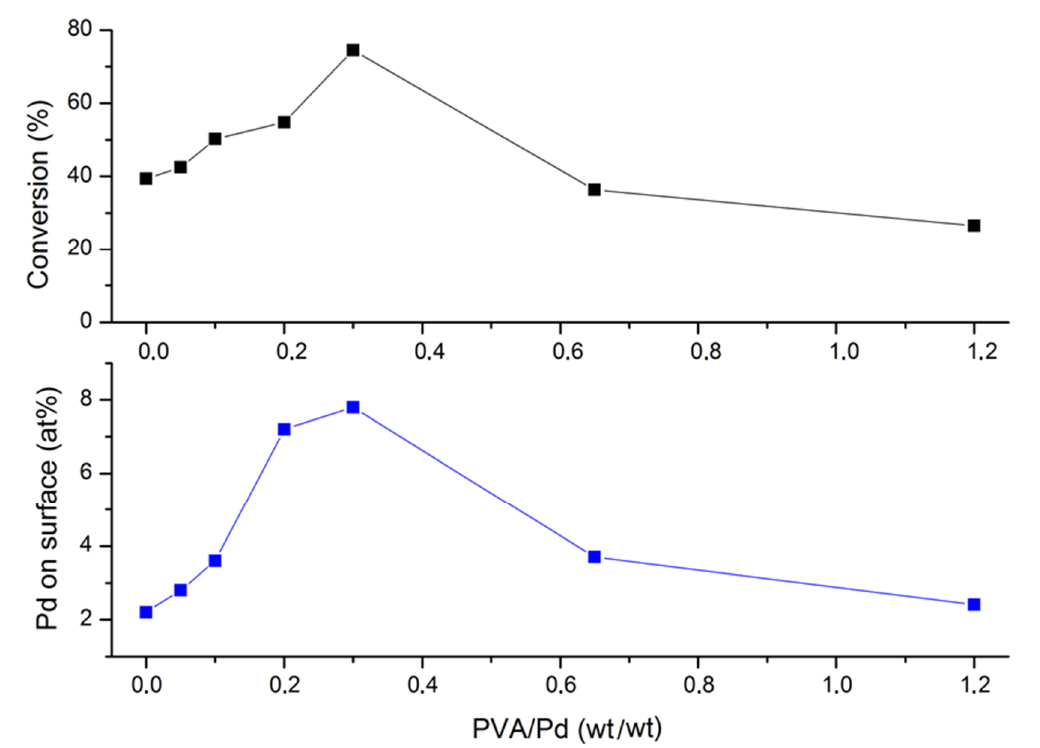
Figure 3. E ff ect of Pd sol preparation on the catalytic performance and on the Pd content on the surface obtained by XPS analysis.